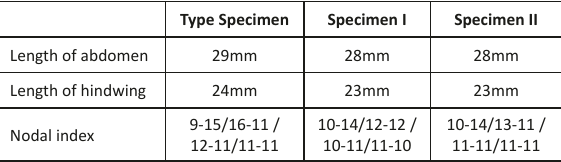
Table 1. Comparison between type specimen described by Fraser (1934) and collected specimen Type